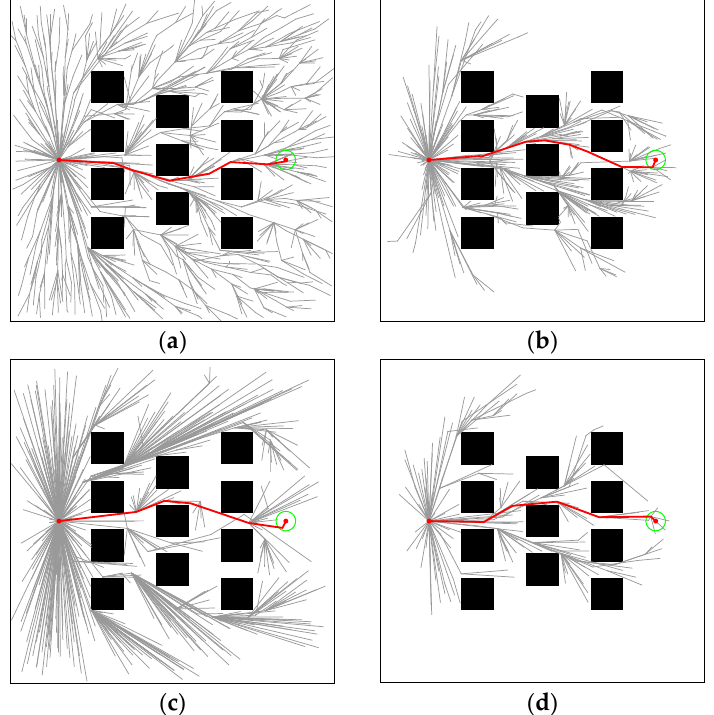
Figure 9. Performance of the four algorithms in the regular environment. ( a ) RRT*. ( b ) Informed- RRT*. ( c ) Q-RRT*. ( d ) M-RRT*. (Red line: approximate optimal path, green circle: goal region.).